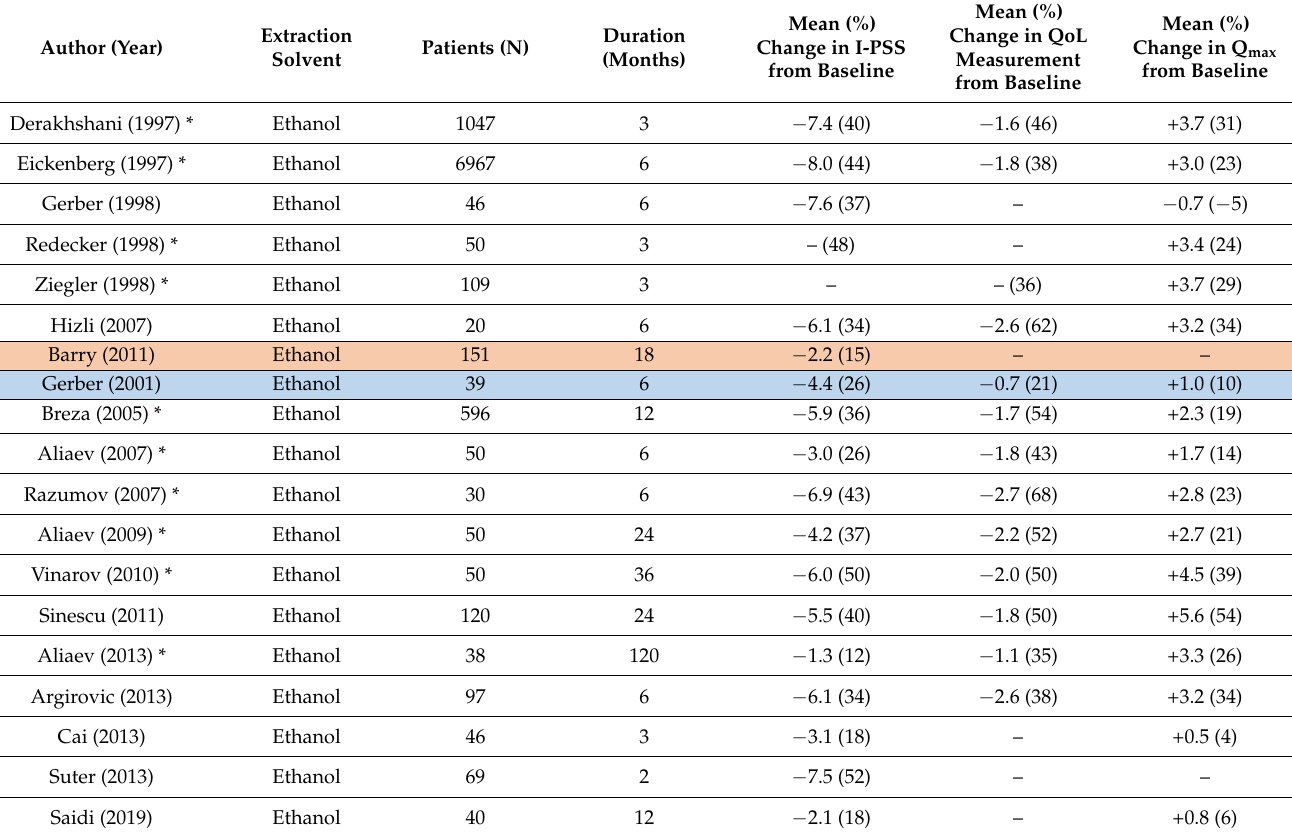
Table 3. Summary of Global Literature Examining the Efficacy of Non-Permixon LSESr